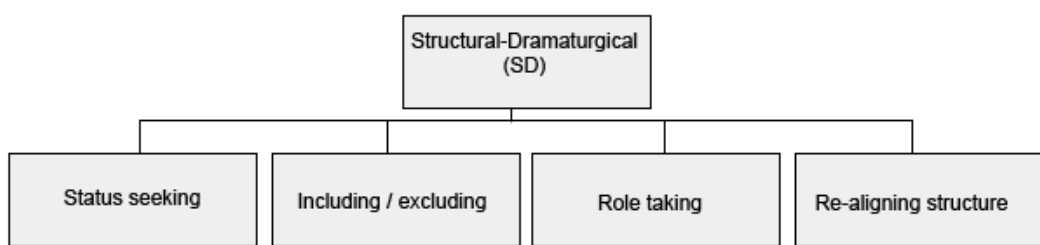
Figure 4 . Structural-dramaturgical